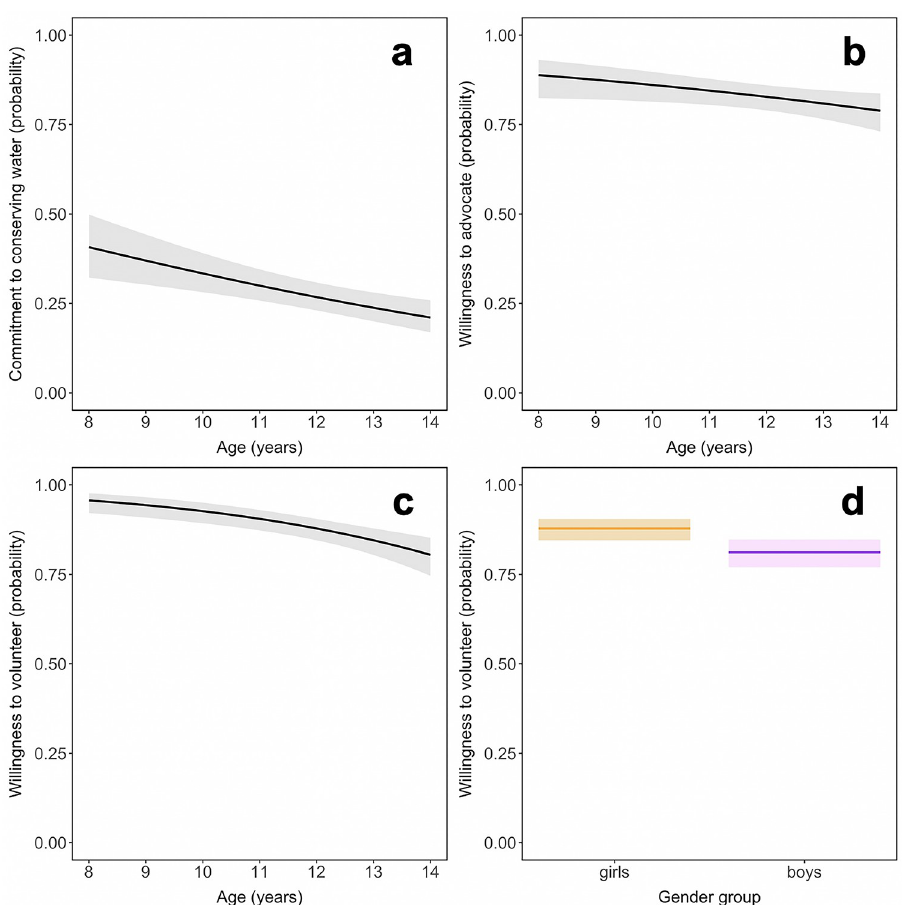
Fig 4. Behavioral outcomes graphed as a function of (a–c) age and (d) gender, independent of connectedness with nature. Trend lines show conditional means with 95% CI shaded. N = 1,037 (569 girls and 468 boys).